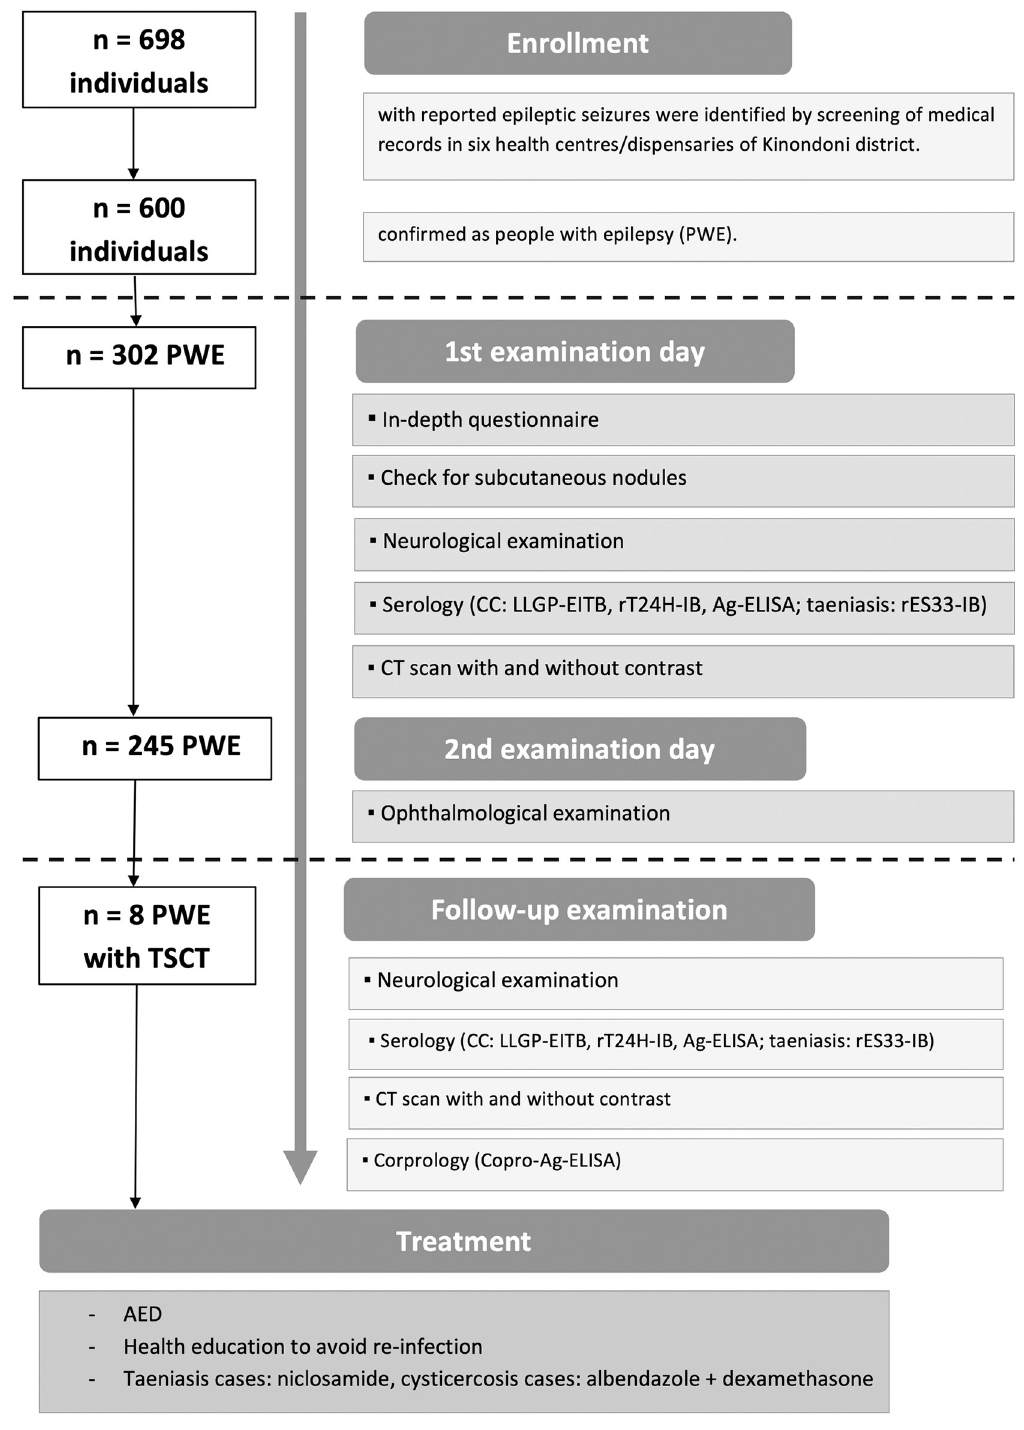
Fig 2. Workflow of recruitment and examinations of people with epilepsy (PWE). CC: cysticercosis; LLGP-EITB: lentil lectin purified glycoprotein enzyme-linked immunoelectrotransfer blot; rT24H-IB: rT24H-immunoblot; Ag: antigen; ELISA: enzyme-linked immunosorbent assay; rES33-IB: rES33-immunoblot; CT: computed tomography; TSCT: T . solium cysticercosis and taeniasis; AED: anti-epileptic drugs.